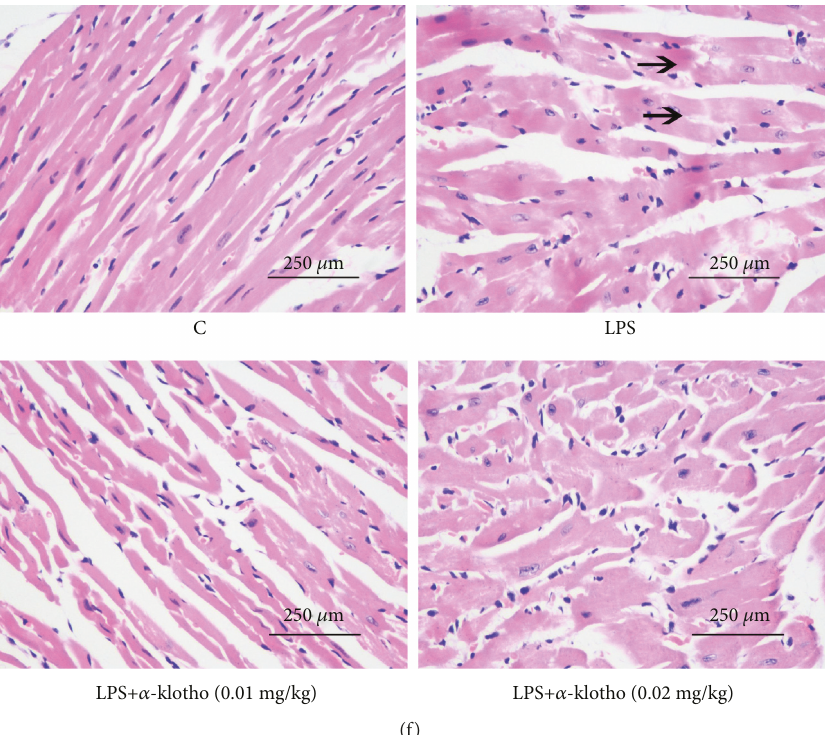
Figure 3: α -Klotho alleviated LPS-induced acute cardiac injury and AKI (a – f). Mice were randomly assigned to four groups ( n = 24 ): control group, LPS group, LPS+ α -klotho (0.01 mg/kg) group, and LPS+ α -klotho (0.02 mg/kg) group. Recombinant α -klotho protein was injected an hour before LPS injection. Serum creatinine (a), NGAL (b), troponin (c) ,and BNP (D) levels were measured at 24 h in all groups by ELISA. Heart and kidney tissues were collected for HE staining (400x) at 24 h in four groups. The lesions in kidneys (e) and hearts (f) were marked with di ff erent arrows. ∗ means p < 0 05 compared with the control group. # p < 0 05 .